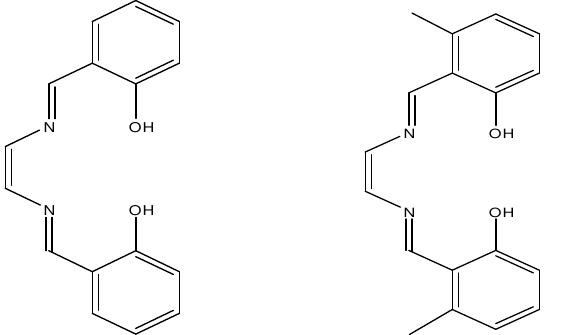
Figure 1. Tetradentate bis-Schiff base Salen and 7,7'- dimethylsalen